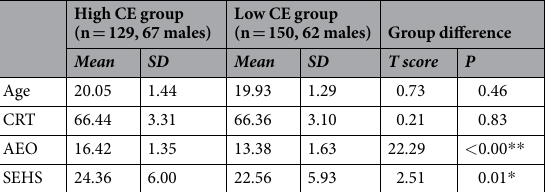
Table 1. Descriptive statistics of behavioral results for high and low cognitive empathy groups. Note: CE, cognitive empathy; CRT, Combined Raven’s Test; AEO, appraisal of the emotion of other; SEHS,